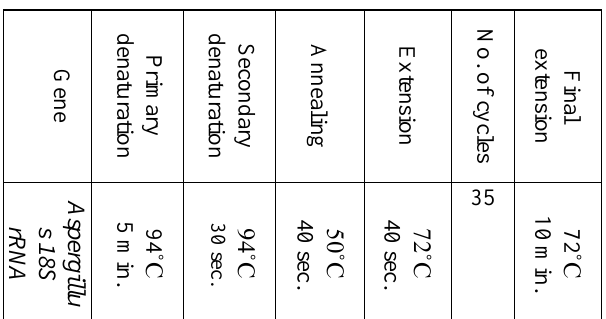
samples. The highest